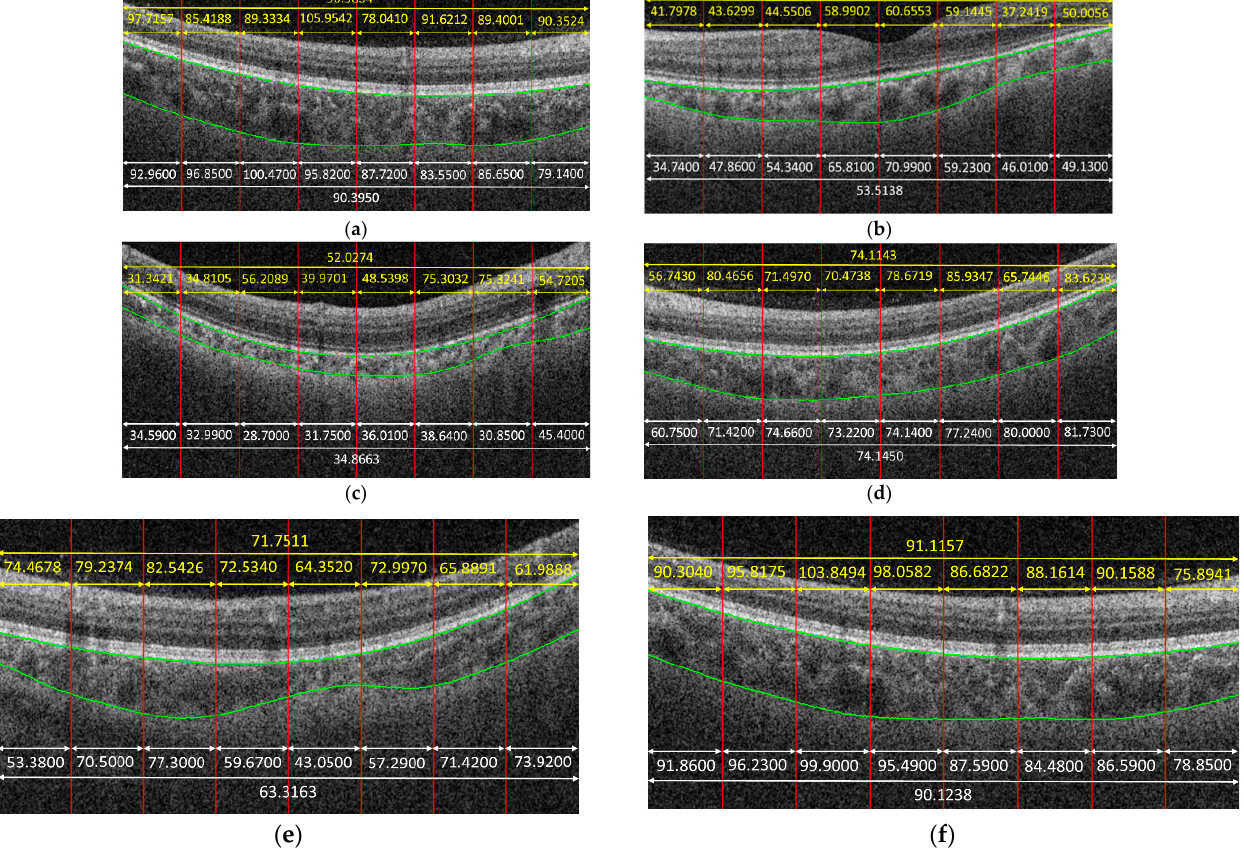
Figure 4. Examples to demonstrate the predicted results obtained by the proposed method, in which yellow parts are the results obtained by the proposed method. White parts are the ground truth. Green curves are the boundaries of choroid. ( a ) MAE = 0.5884, ( b ) MAE = 4.0118, ( c ) MAE = 17.1611, ( d ) MAE = 0.0307, ( e ) MAE = 8.4348, ( f ) MAE = 0.9919.